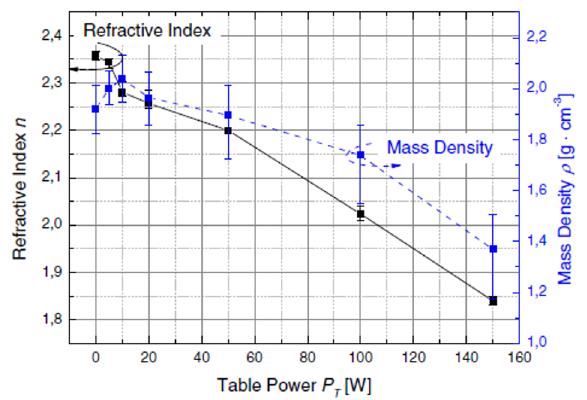
Figure 6. Evolution of the refractive index (left) and the density (right) as a function of the power applied on the substrate P T measured by Frischmuth team [83]. Reprinted with permission from El-